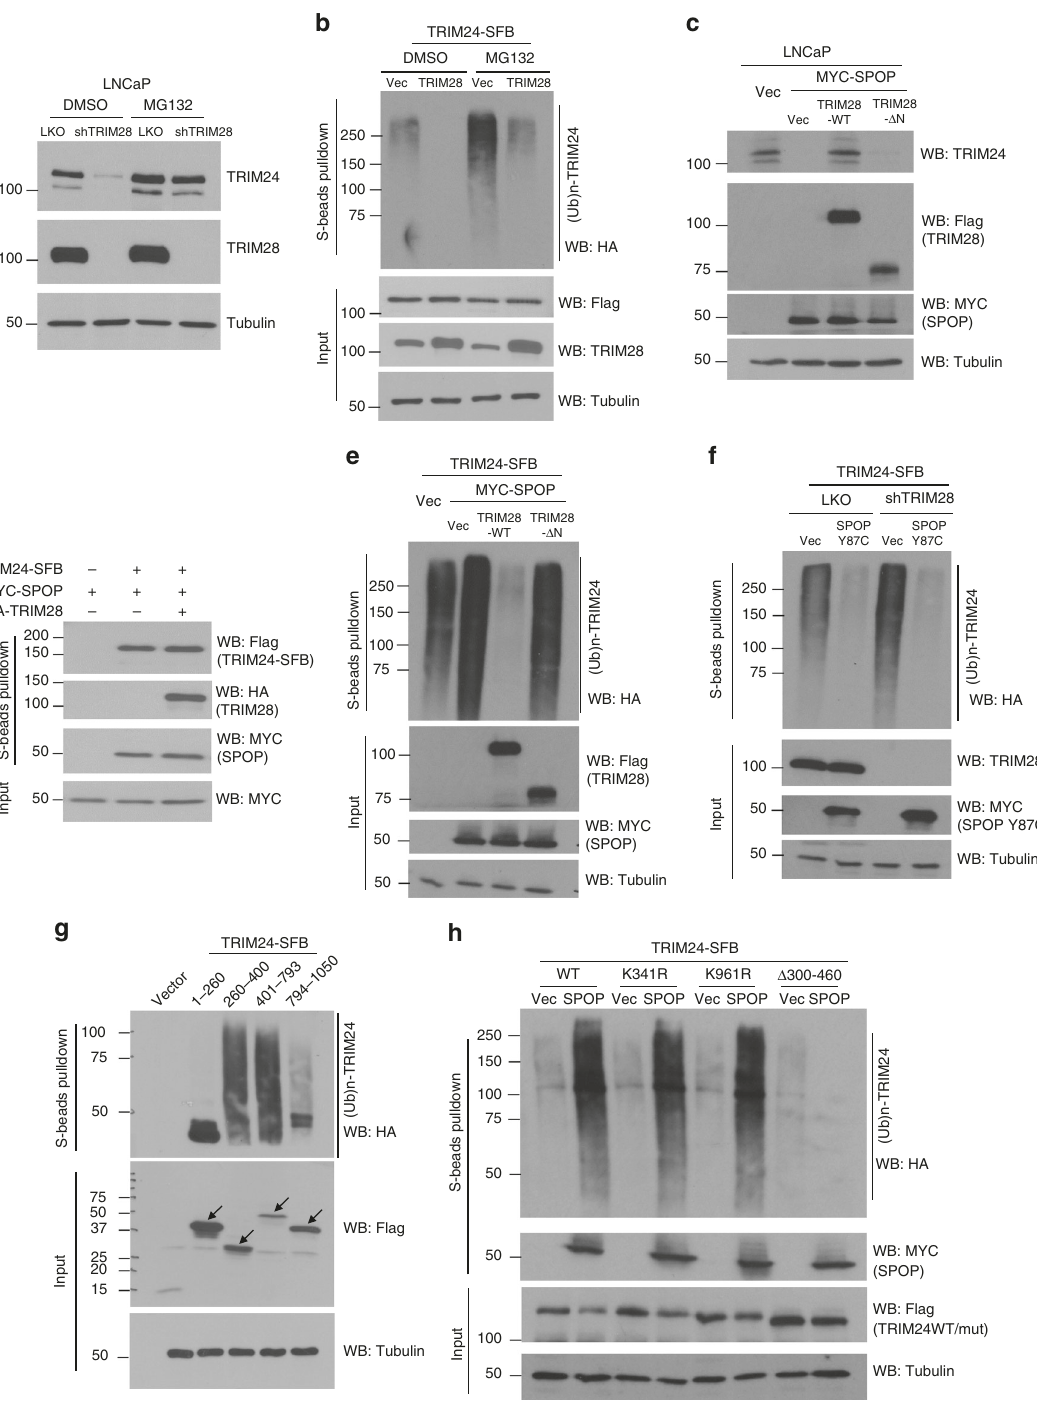
experiment taking advantage of an N-terminal deletion mutant (TRIM28- Δ N) that is unable to interact with TRIM24. LNCaP cells were subjected to TRIM28 knockdown followed by concomitant re-expression of control, wild type, or Δ N TRIM28 constructs. Western blot analysis indicated that wild type, but not TRIM28- Δ N, restored TRIM24 protein that were lost upon TRIM28 knockdown (Fig. 2h). In aggregates, these data support that TRIM28 protein interacts with TRIM24 protein to enhance its stability.